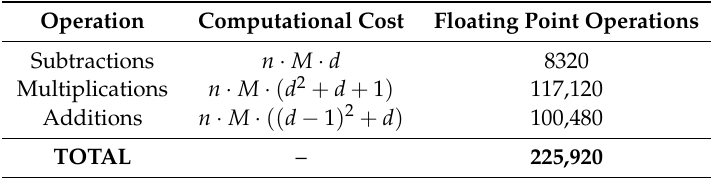
Table 5. Computational cost of the Gaussian Mixture Models (GMM) algorithm for the evaluation of n probabilities of each frame of 30 ms, where n is the number of classes, M the number of Gaussians and d the dimension of the features.